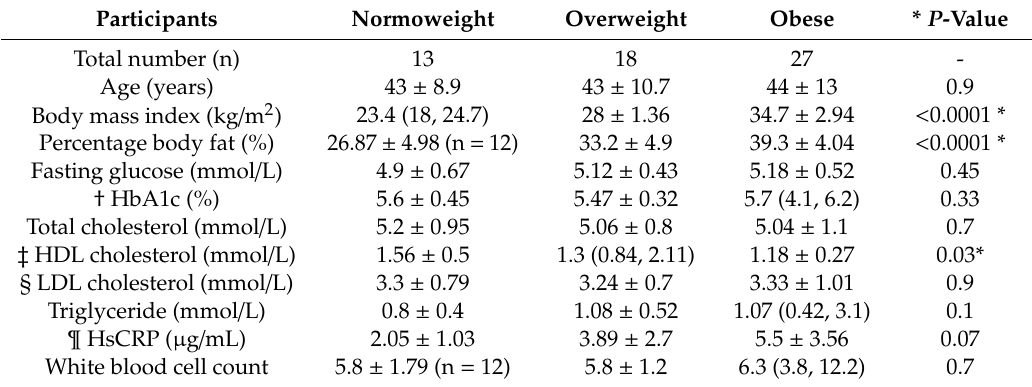
Table 2. Anthropometric and biochemical characteristics of the study